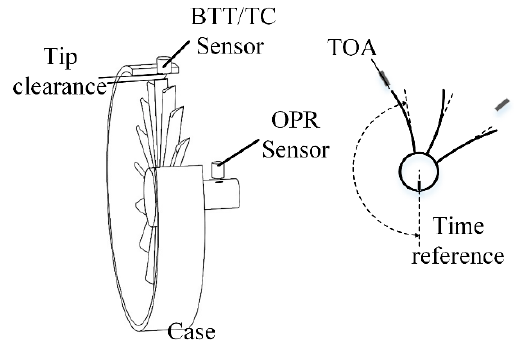
Figure 1. Blade tip timing method.